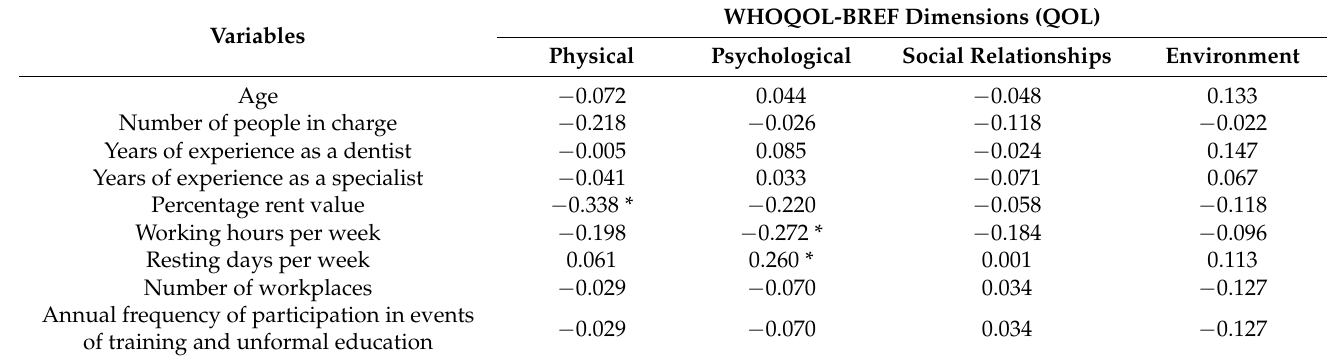
Table 2. Bivariate correlations between the WHOQOL-BREF dimensions of quality of life and the sociodemographic, labor and health variables in the study sample. Medellin, 2021–2022 ( n = 62). WHOQOL-BREF Dimensions Variables